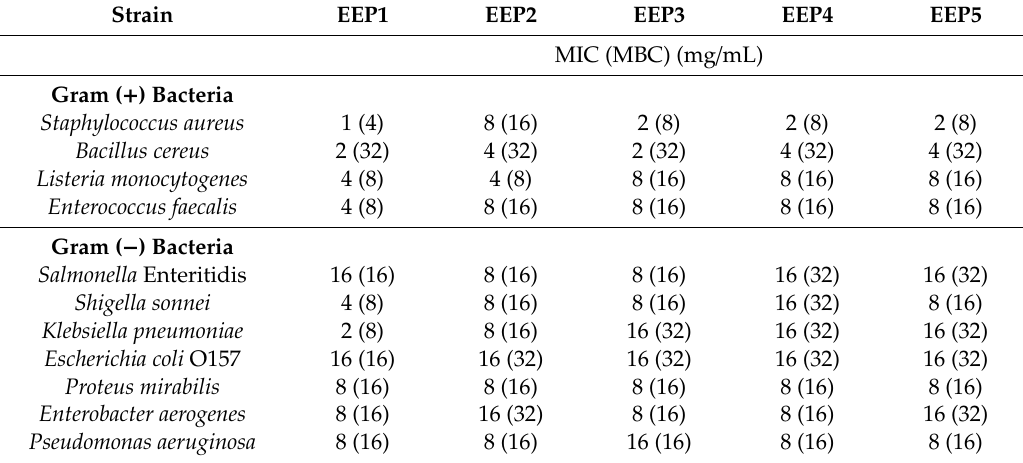
Table 4. Antibacterial activity of ethanol extracts of propolis.